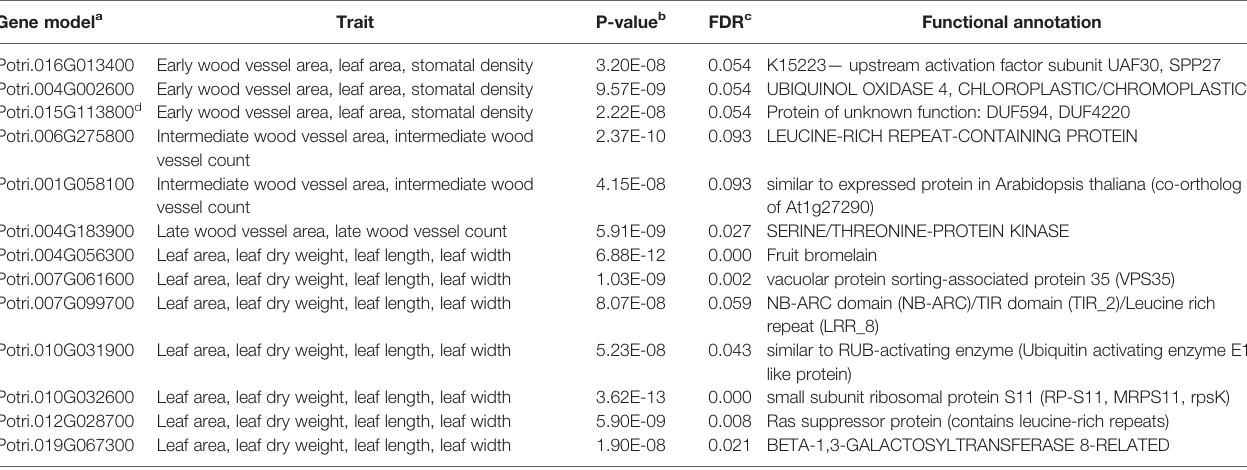
TABLE 4 | Genes identi fi ed from P. trichocarpa multitrait